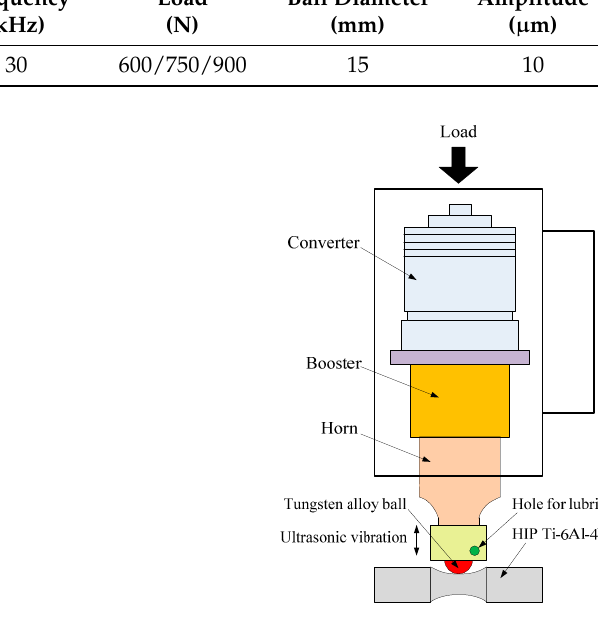
Figure 2. The schematic diagram of MUSR (multi-pass ultrasonic surface rolling) treatment. Table 2. MUSR (multi-pass ultrasonic surface rolling) processing